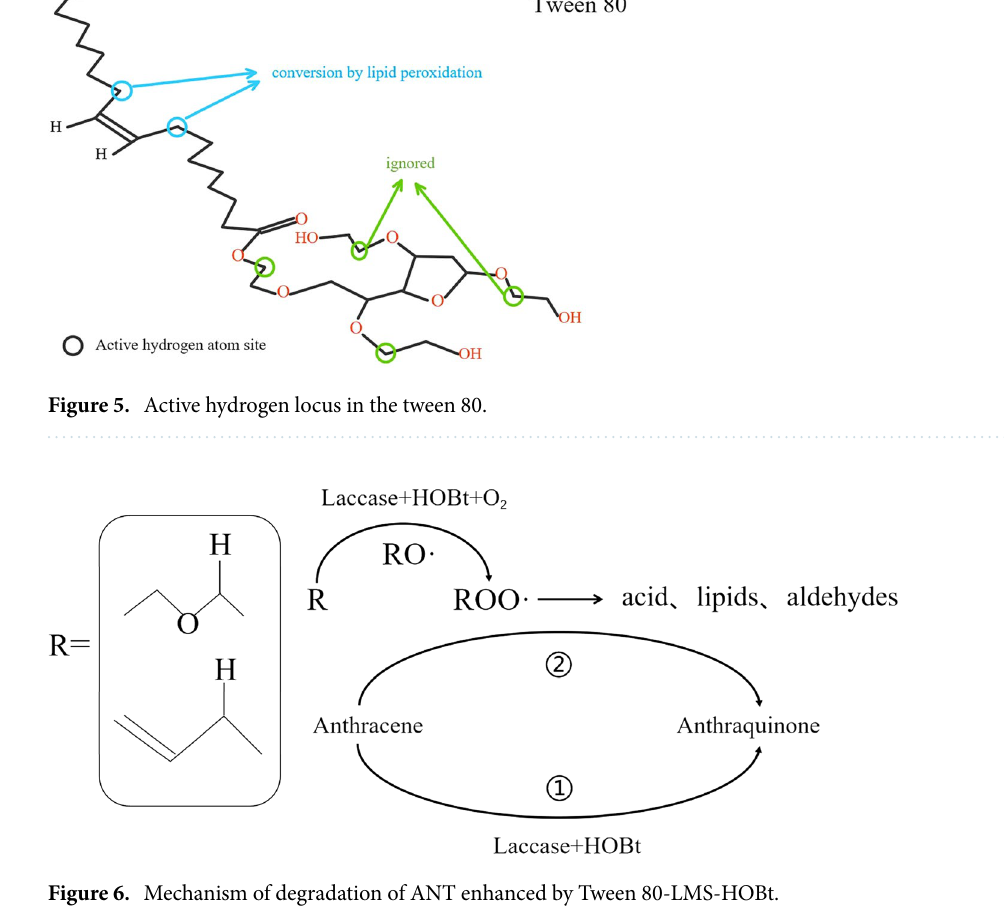
Figure 6. Mechanism of degradation of ANT enhanced by Tween